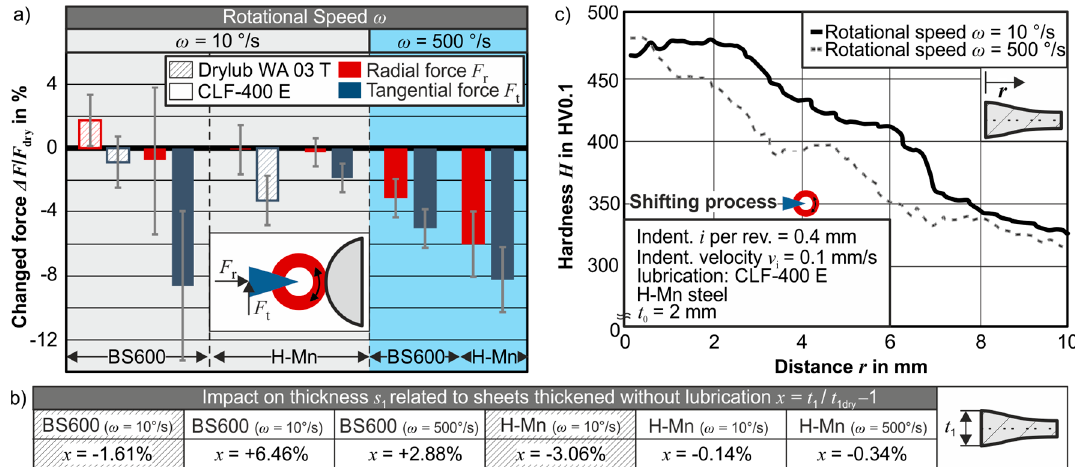
Figure 6. Impact of rotational speed and lubrication on the ( a ) forming force F ( b ) related to the sheet thickness and ( c ) hardness distribution H at the shifting process.